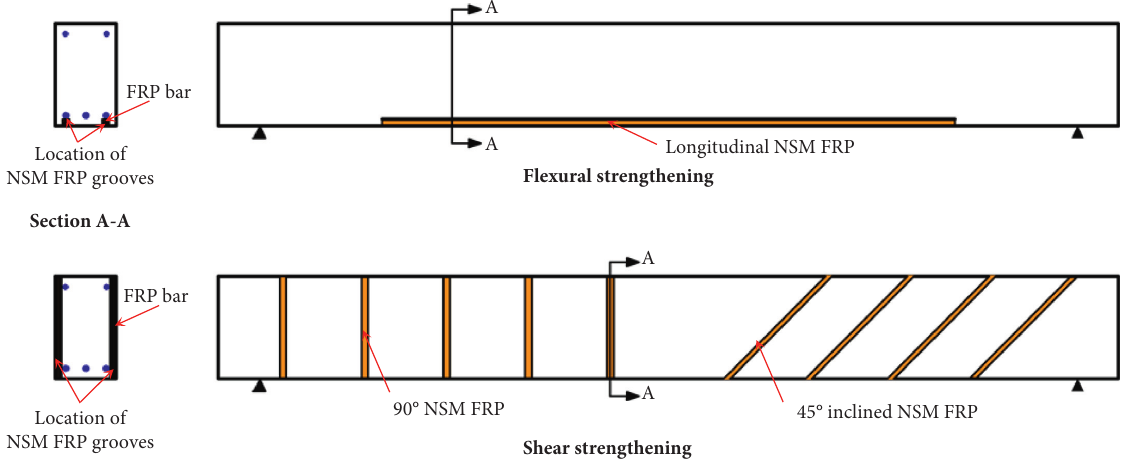
Figure 1: NSM FRP strengthening of beams in flexure and